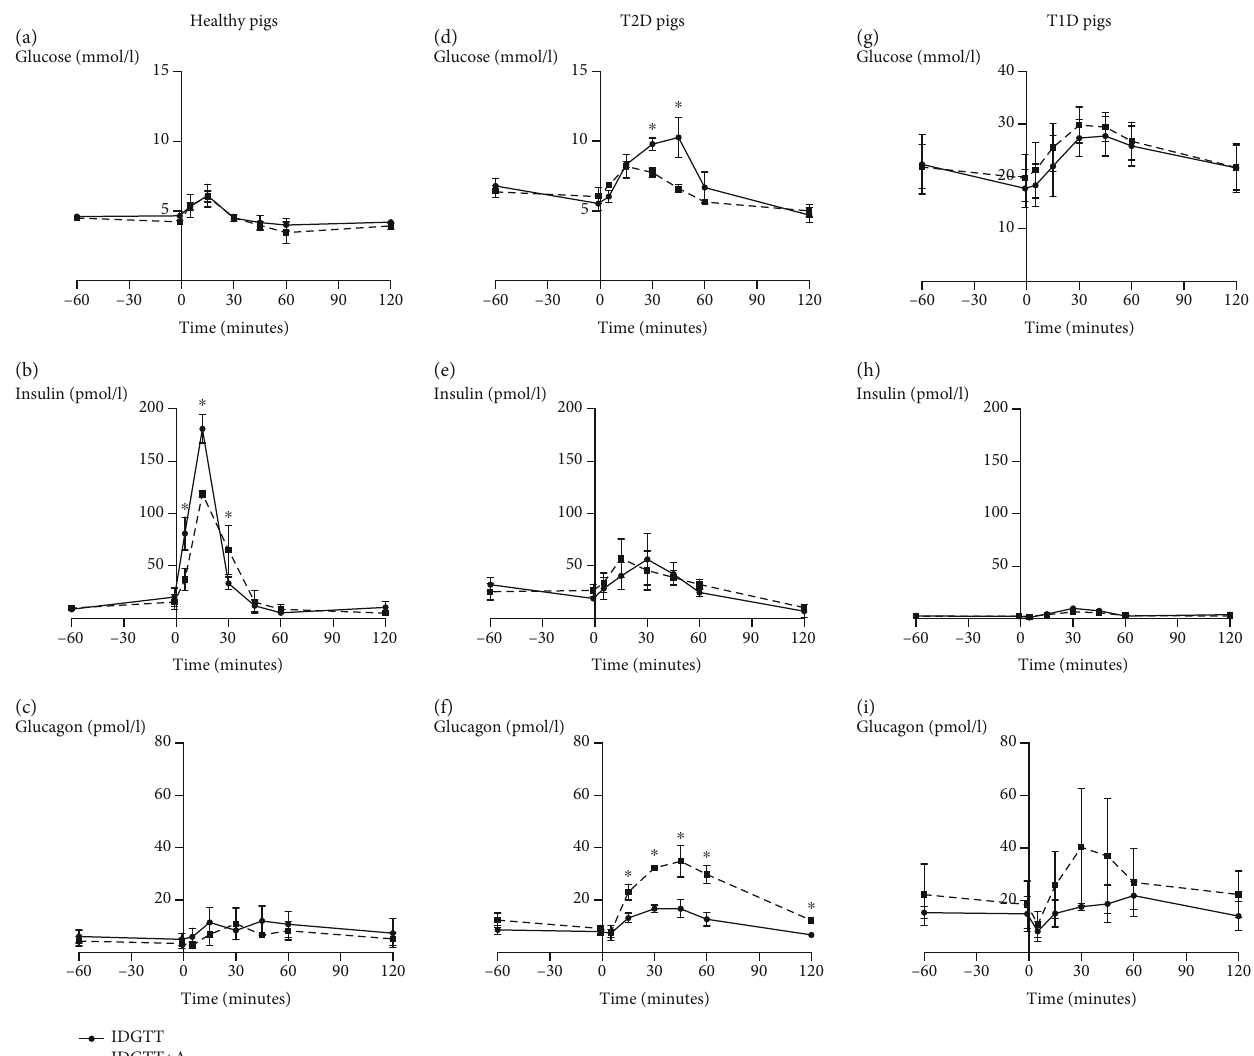
Figure 3: Plasma parameters in healthy pigs ( n = 4 ) (a – c); pigs with STZ-induced type 2-like diabetes mellitus, which were administered STZ at 110mg/kg bw ( n = 4 ) (d – f); and pigs with STZ-induced type 1-like diabetes mellitus, which were administered STZ at 150 mg/kg bw ( n = 4 ) (g – i). Blood glucose levels (a, d, g), plasma insulin (b, e, h), and glucagon concentrations (c, f, i) during an intraduodenal glucose tolerance test (IDGTT), either alone or together with an intravenous pancreatic amylase infusion (IDGTT+A). Data were analyzed using a paired Student t -test and are presented as m ean ± SD . ∗ describes signi fi cant di ff erences between IDGTT and IDGTT+A in corresponding time points when p < 0 : 05